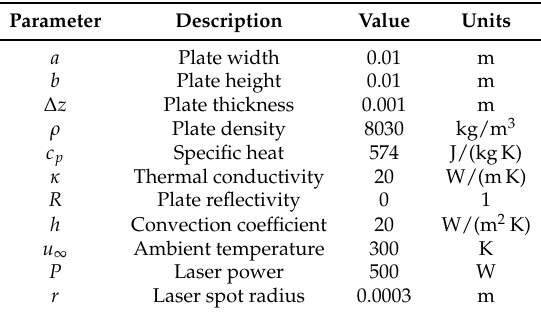
Table 2. Parameters for the physical